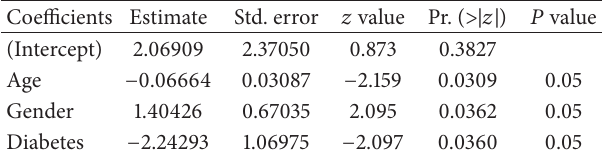
Table 5: Predictors of alcohol